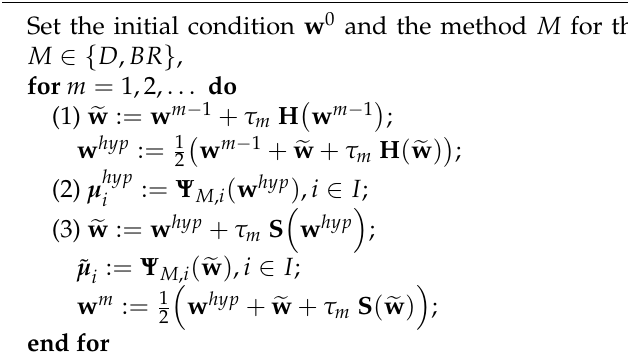
Algorithm 1 Runge-Kutta